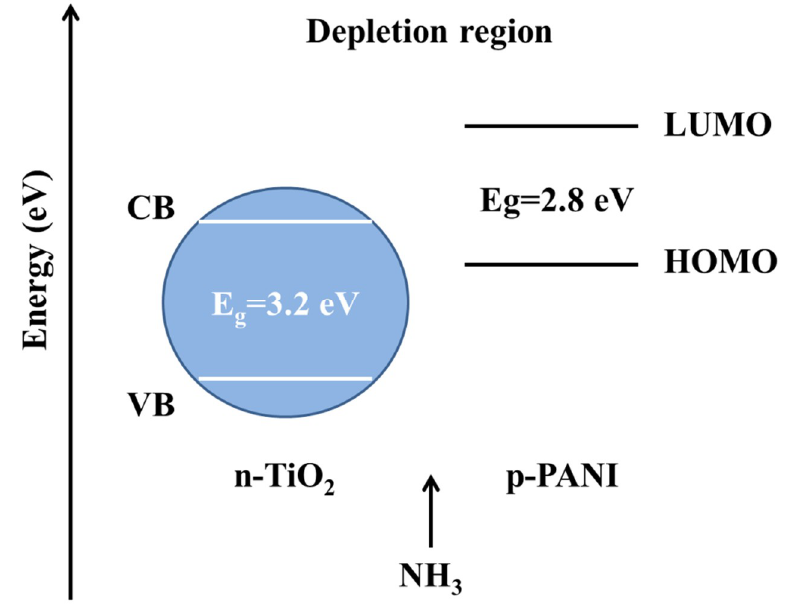
Figure 10. The schematic energy diagram of the composites of PANI and TiO 2 NPs.